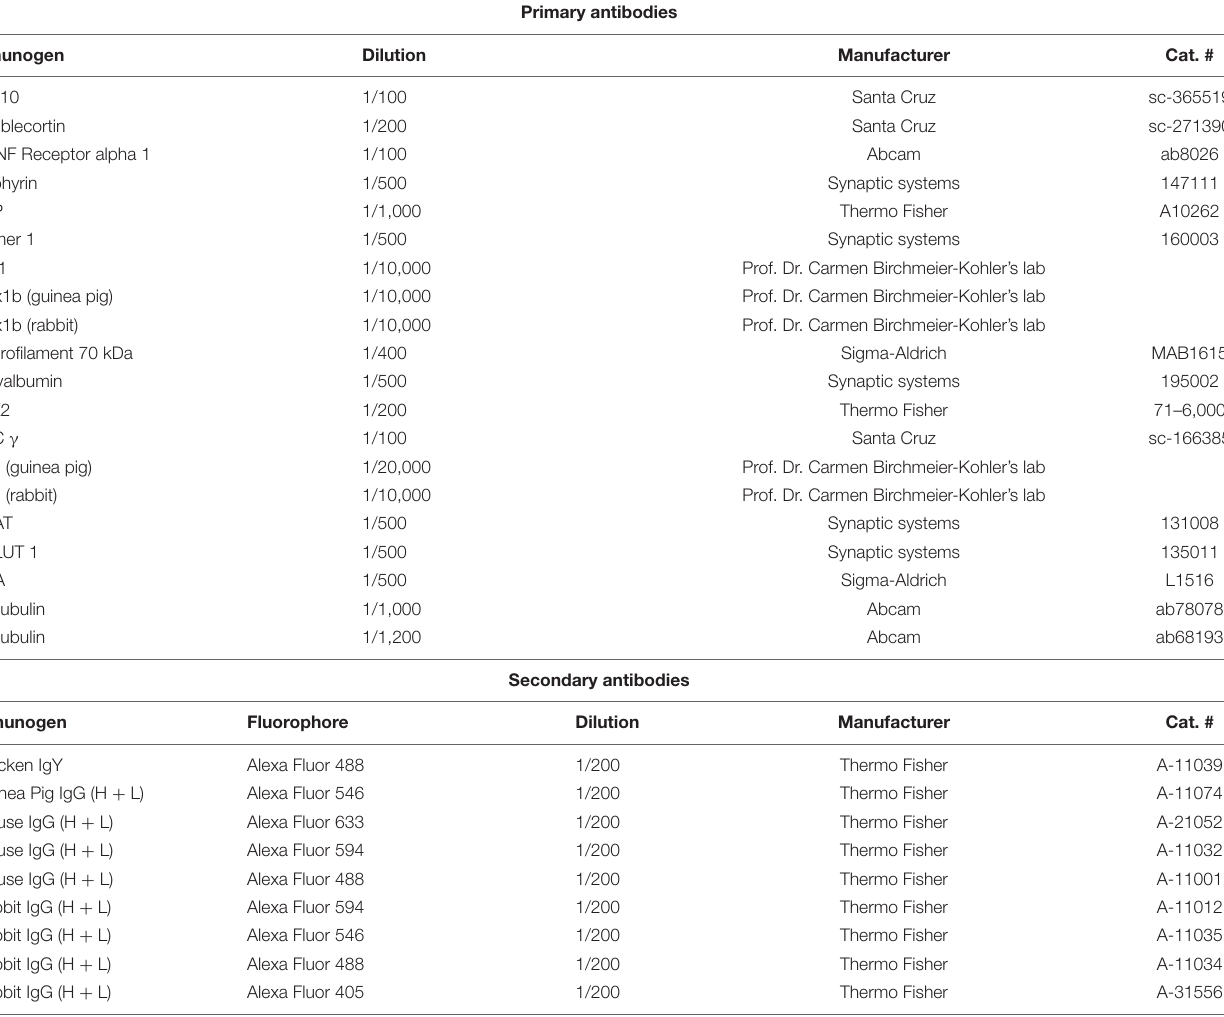
TABLE 2 | List of antibodies used for immunocytochemistry.